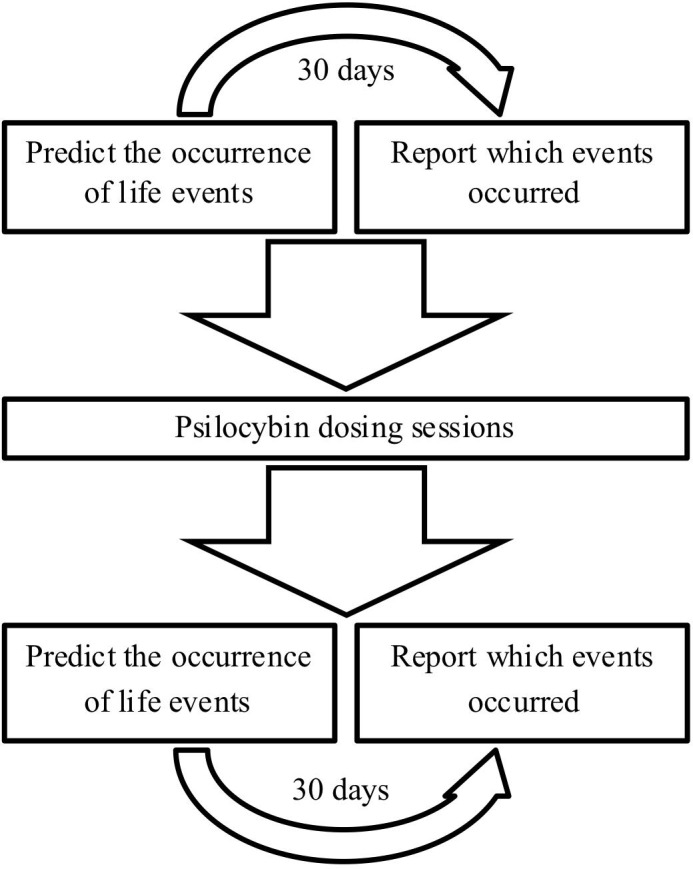
Schematic diagram of the study design.